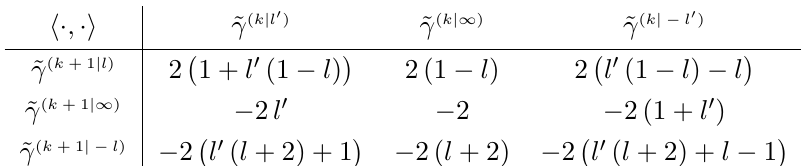
Table 1 . Intersection pairings for different states at level k + 1 with other states at level k . Here l, l 0 0 except for the first row, where l ≥